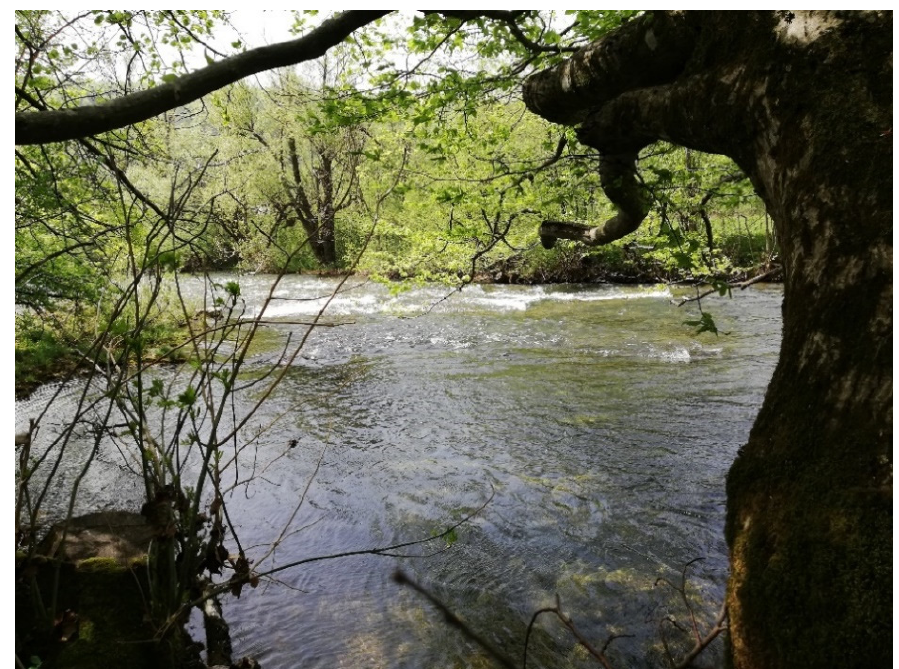
Figure 9. View of the measuring station Turkovi ć i on the river Gornja Dobra.